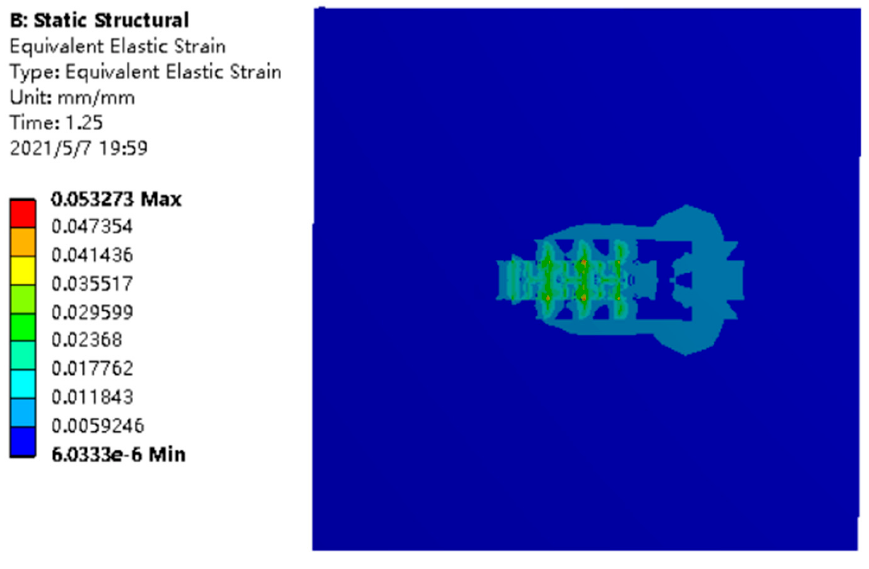
Figure 11. Equivalent strain under thermal stress.